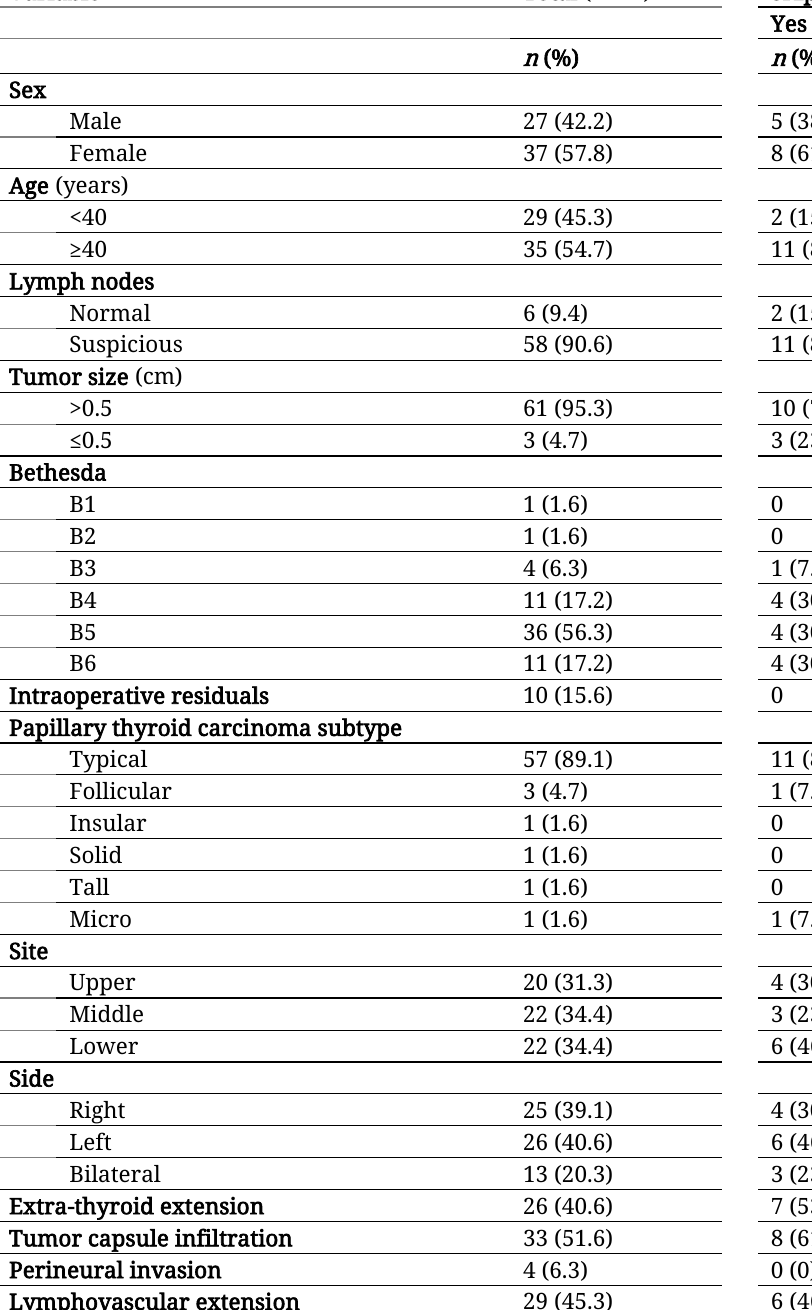
Table 1: Comparisons between patients with and without skip metastasis